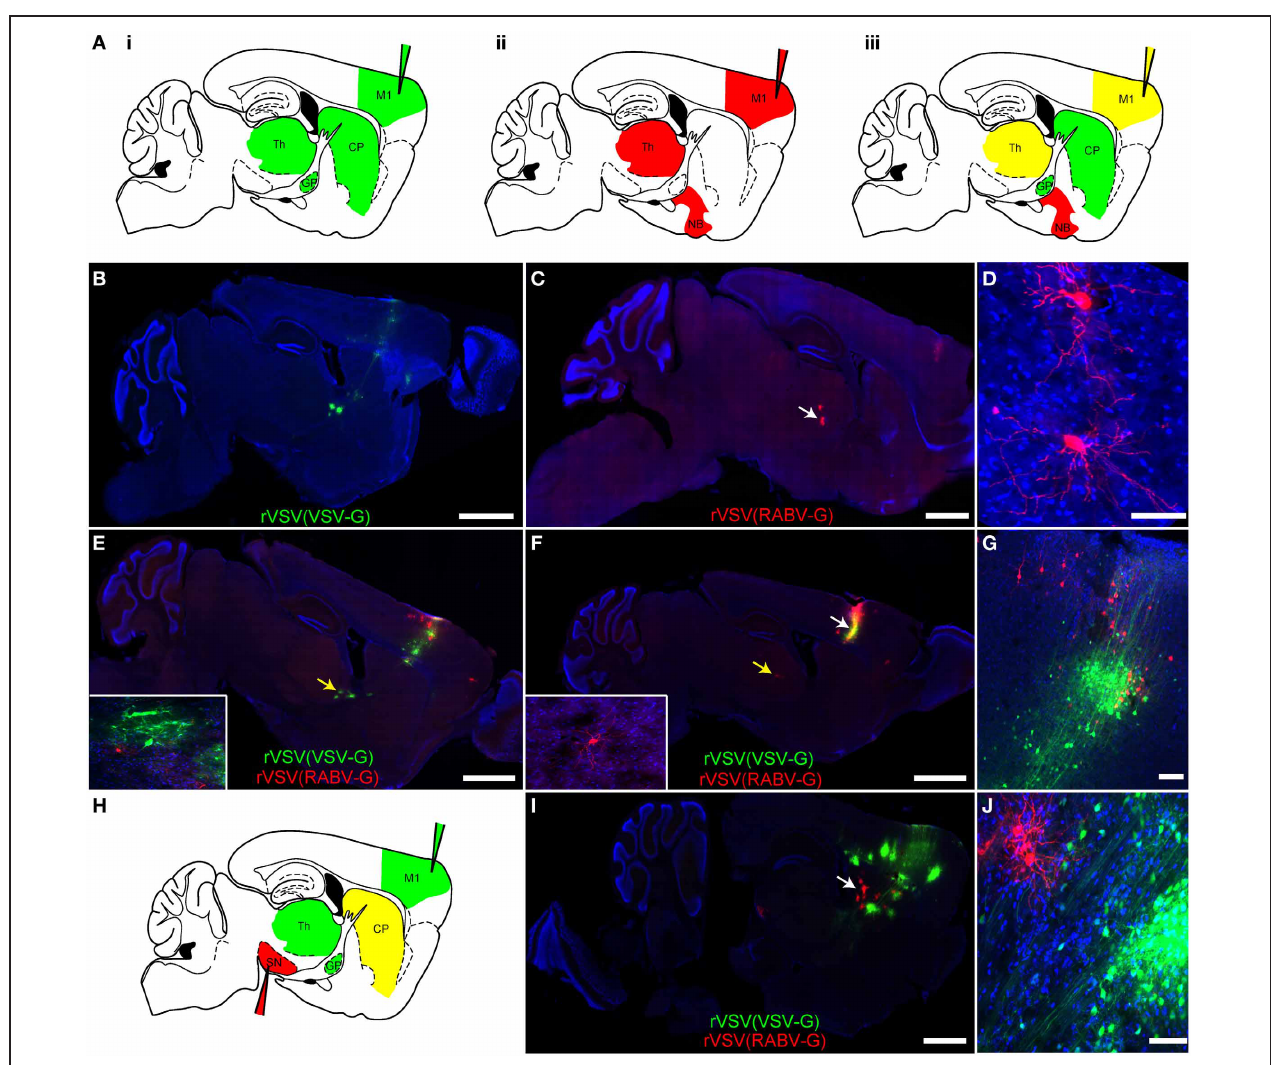
FIGURE 6 | Simultaneous anterograde and retrograde transsynaptic circuit tracing using rVSV. (A) Connectivity schematics of parasaggital sections indicating patterns of spread from injection of M1 (injection needles) with a polysynaptic virus transmitting across synapses in the (i) anterograde or (ii) retrograde directions. Panel (iii) shows the pattern from co-injection of two polysynaptic viruses, one anterograde and one retrograde. Green represents the anterograde virus, red the retrograde virus, and yellow, both. Note that yellow indicates that the area is predicted to host infection by both viruses, with potentially some individual cells showing infection with both viruses. (B) The anterograde transsynaptic virus rVSV(VSV-G), when injected alone, labeled M1 as well as anterograde projection areas, such as the CP, GP, and thalamus, whereas (C) the retrograde virus rVSV(RABV-G) labeled M1 as well as areas projecting to the cortex, including the thalamus. (D) High magnification of thalamic cells shown in (C) (white arrow). (E,F) Examples taken from a series of parasaggital sections from the same brain of an animal injected with both viruses simultaneously into M1. Co-infection of cells in M1